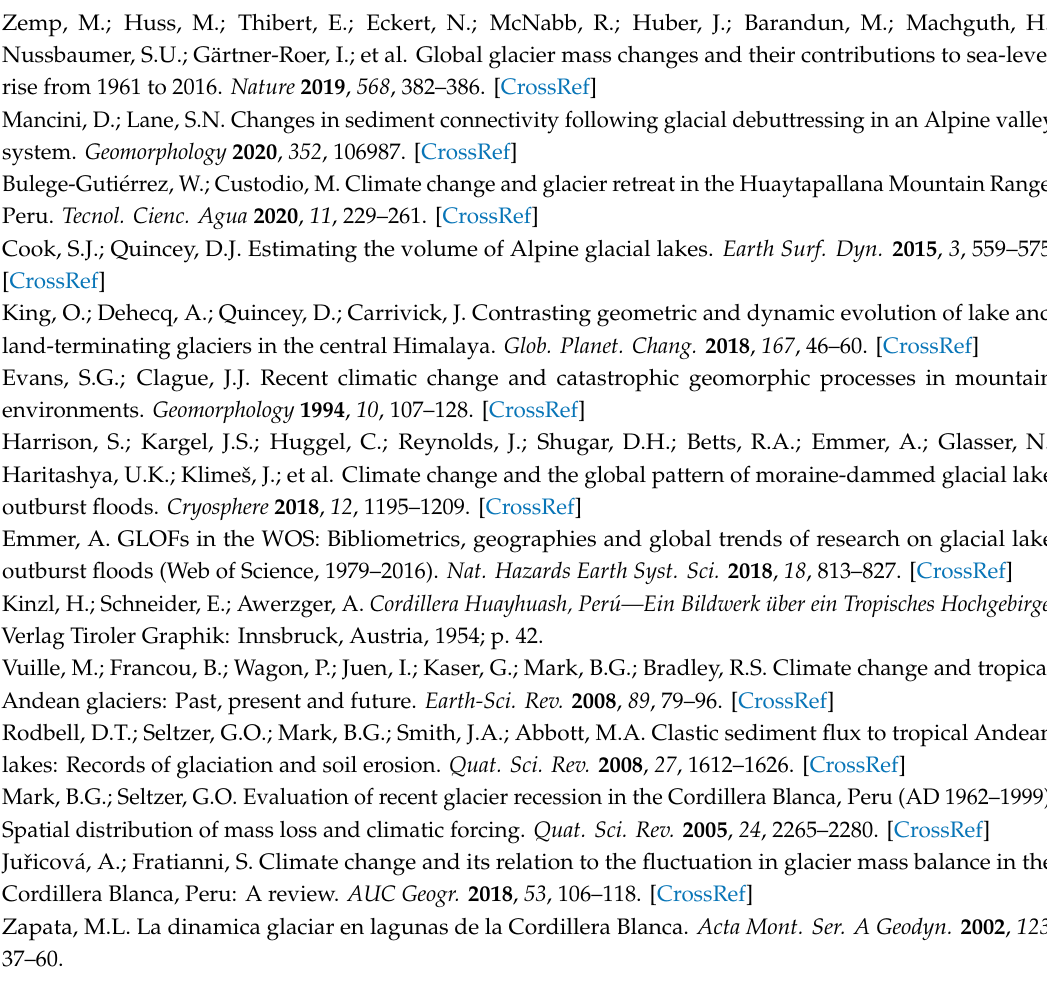
Figure S1: detected GLOFs and ambiguous events, Table S1: lake axis orientation of the 270 lakes of the Cordillera Huayhuash, Table S2: GLOF susceptibility of lakes in the Cordillera